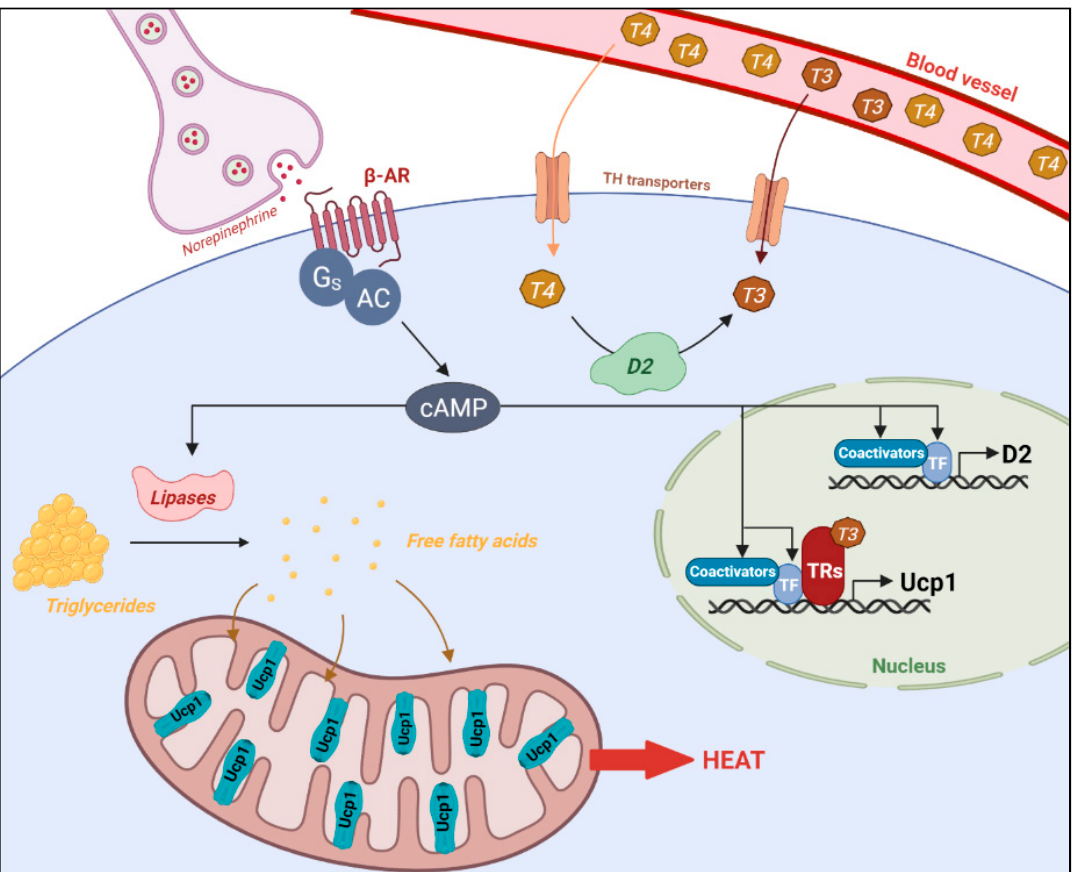
Figure 2. Control of brown adipocyte UCP1-dependent thermogenesis by norepinephrine and thyroid hormone . Sympa- thetic neurons release synaptic norepinephrine that binds to β -adrenergic receptors ( β -AR) coupled to stimulatory guanine nucleotide binding protein (Gs) which activates adenylate cyclase (AC) to produce cAMP. This adrenergic signaling activates transcription factors (TF) and coactivators involved in the regulation of D2 . Both adrenergic signaling and thyroid hormone receptors (TRs) regulate Ucp1 expression. Triglycerides are broken down into free fatty acids by lipases and transported to mitochondria to fuel the β -oxidation and activate UCP1. UCP1 uncouples ATP production from respiration, requiring an increased mitochondrial activity and heat is produced.